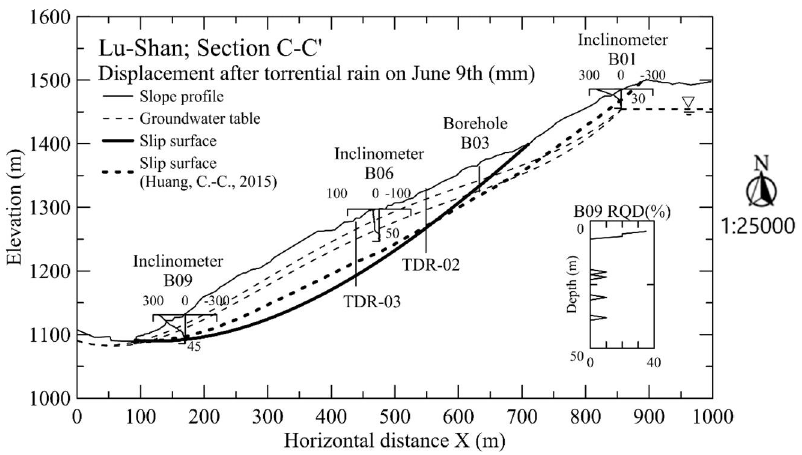
Figure 12. Locations and plan view of studied slope.